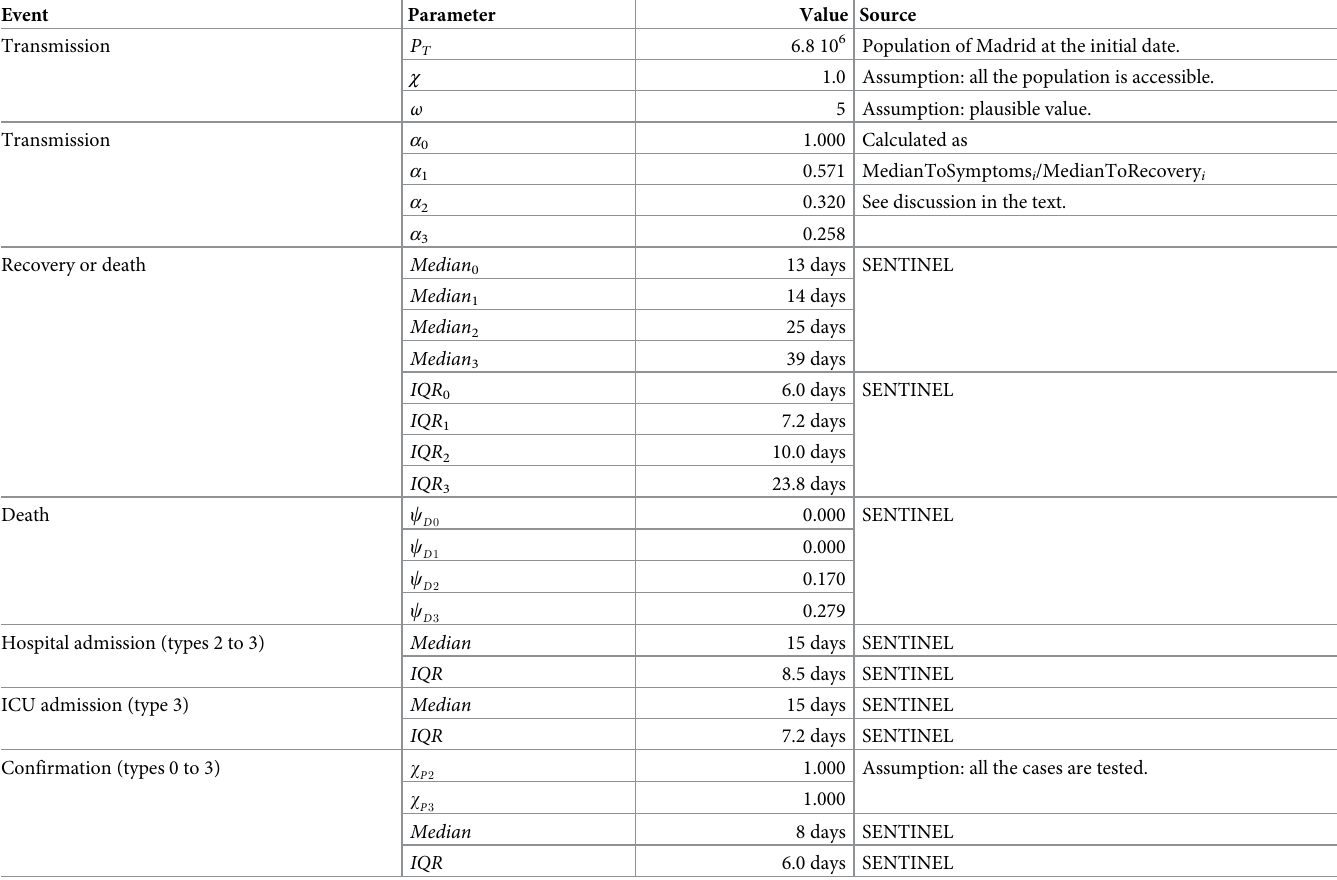
Table 2. Values used in the C-model for the fixed input